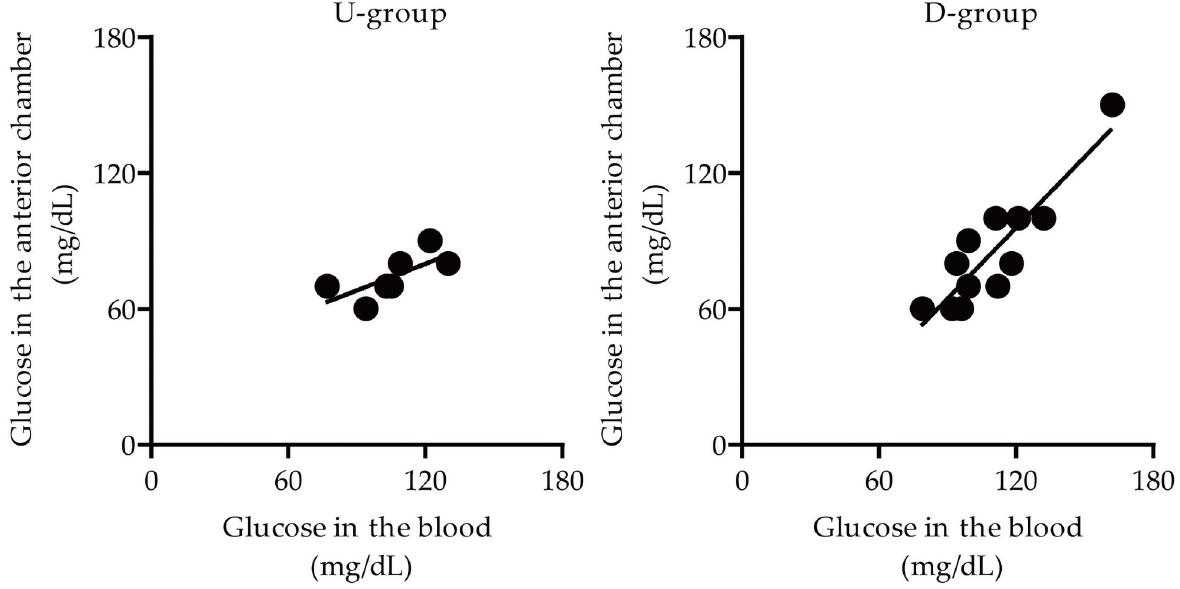
Fig 4. Visualization of a correlation on glucose levels between the anterior chamber and blood in Study 2 subjects with cataracts based on the values in Table 3. Dots represent the measured glucose levels. Lines represent the linear fit of the data points. U: up, D: down.